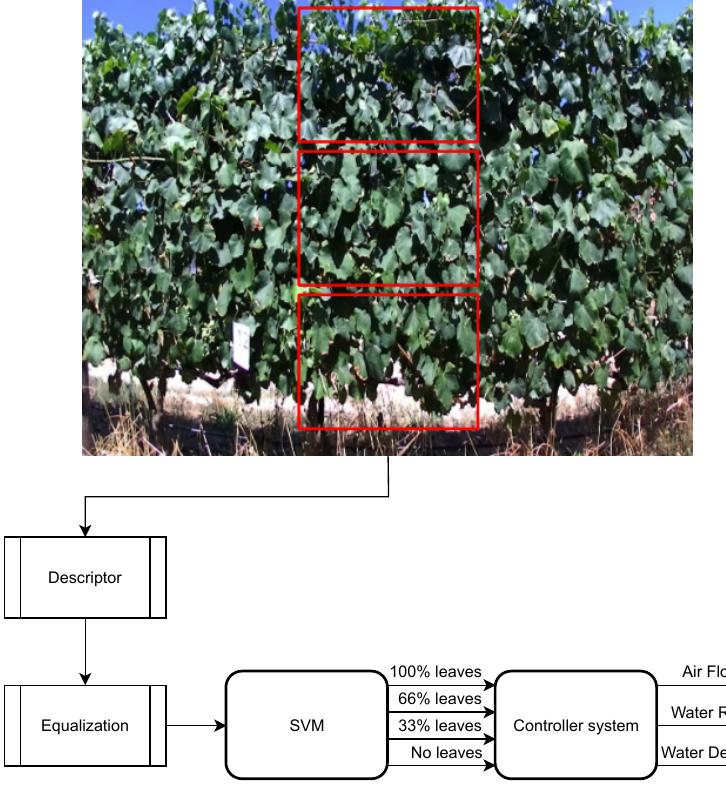
Figure 6. Software architecture.